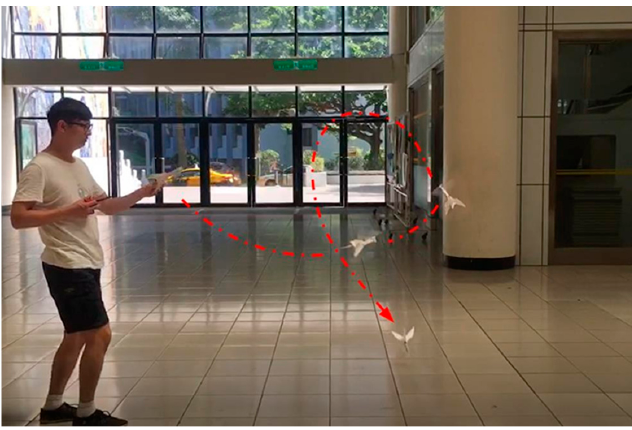
Figure 12. Flight testing of the FWMAV using check valves.